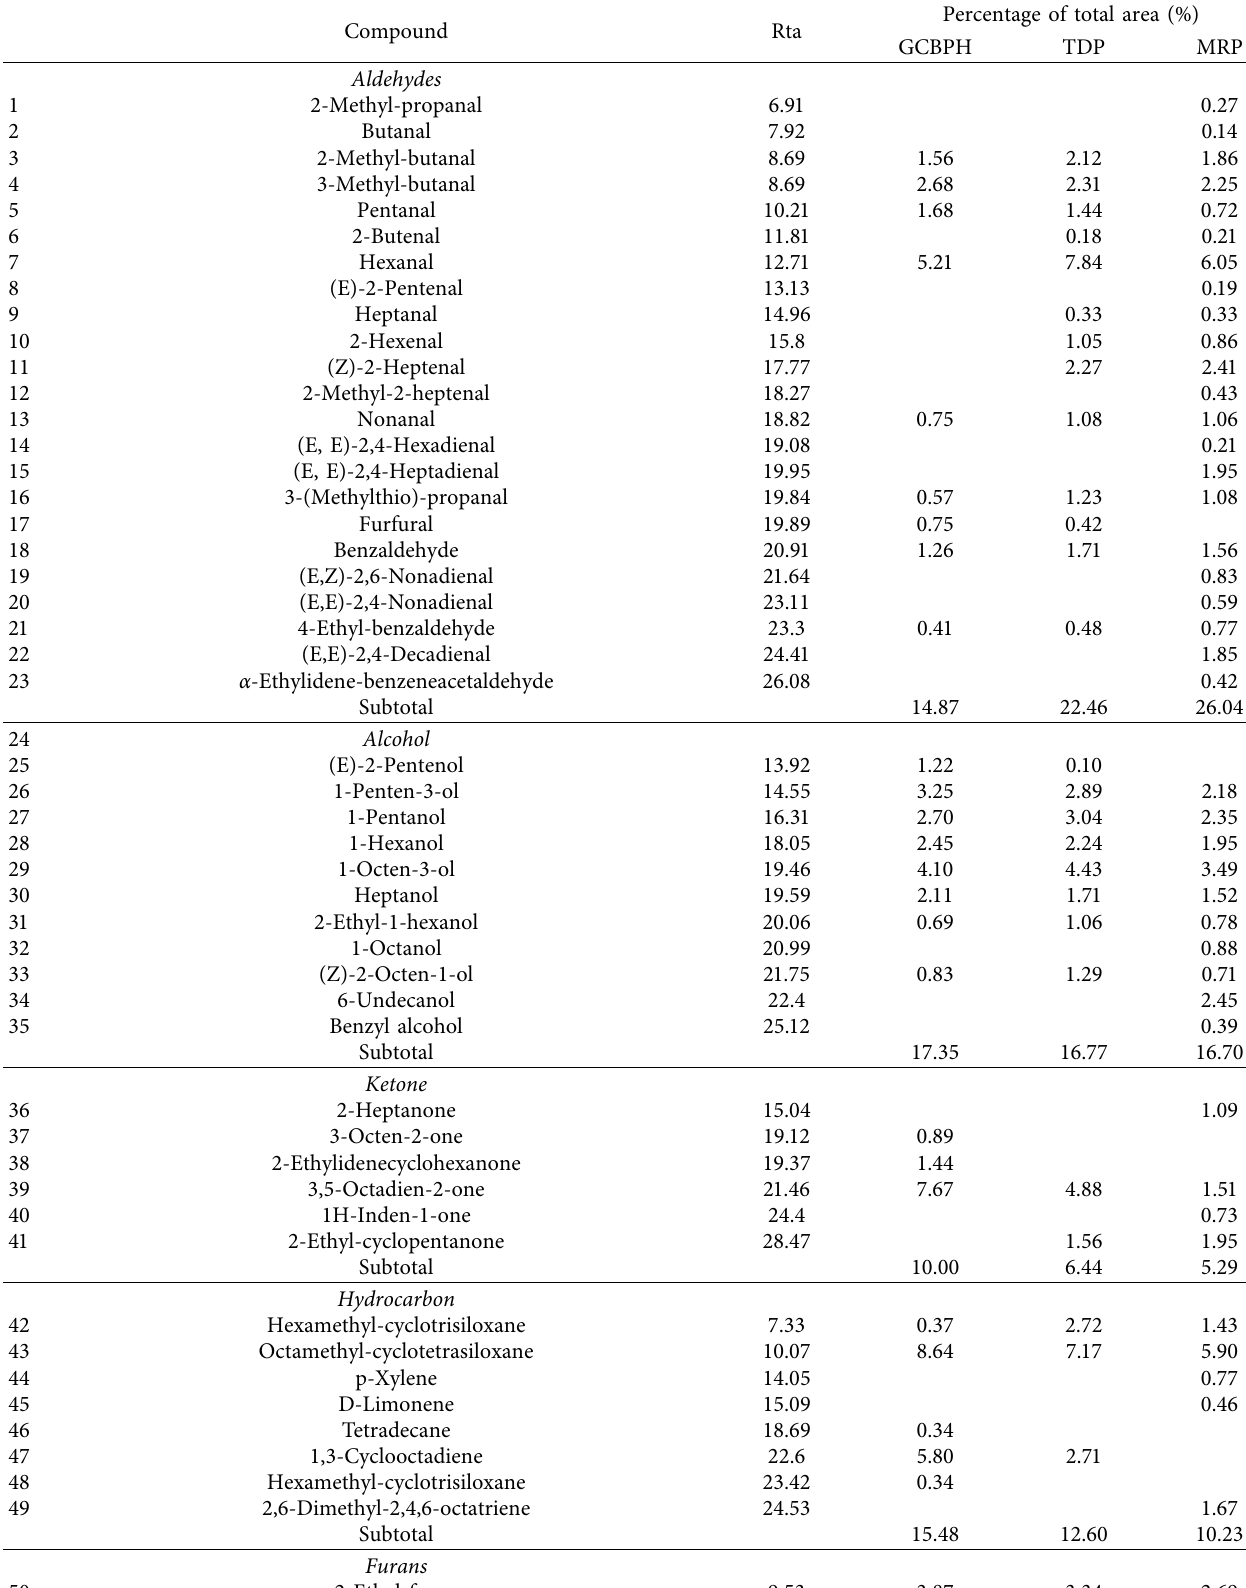
Table 3: Volatile Compounds identified in GCBPH, TDP, and MRP by DHS